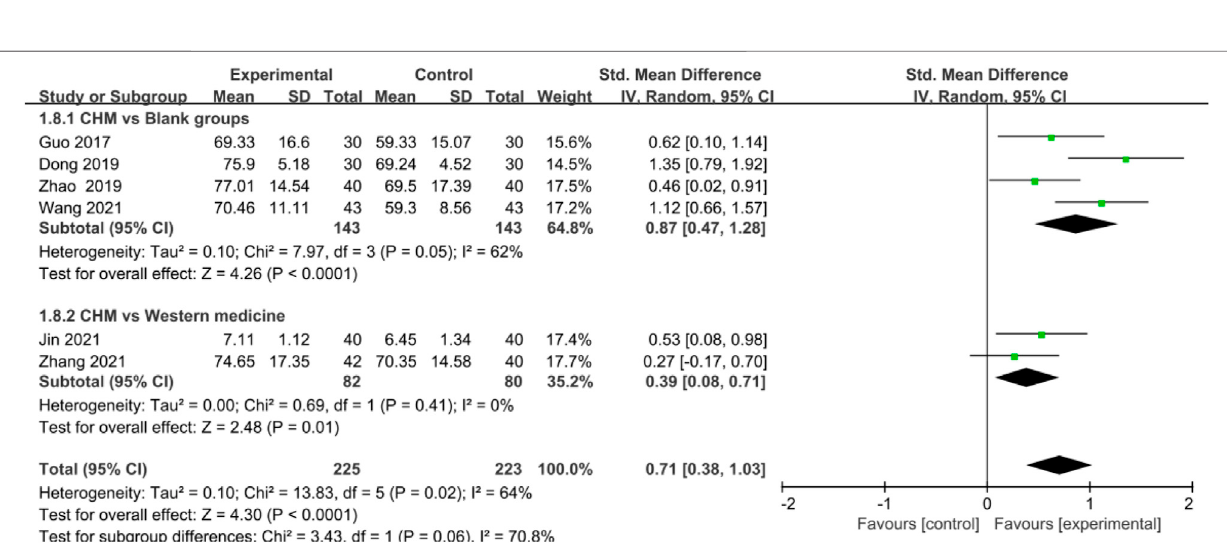
FIGURE 5 | Forest plot: CHM for improved AF in CHD with anxiety compared with control groups.